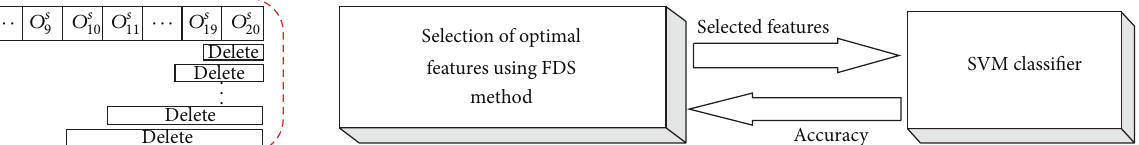
Figure 7: Feature selection process.